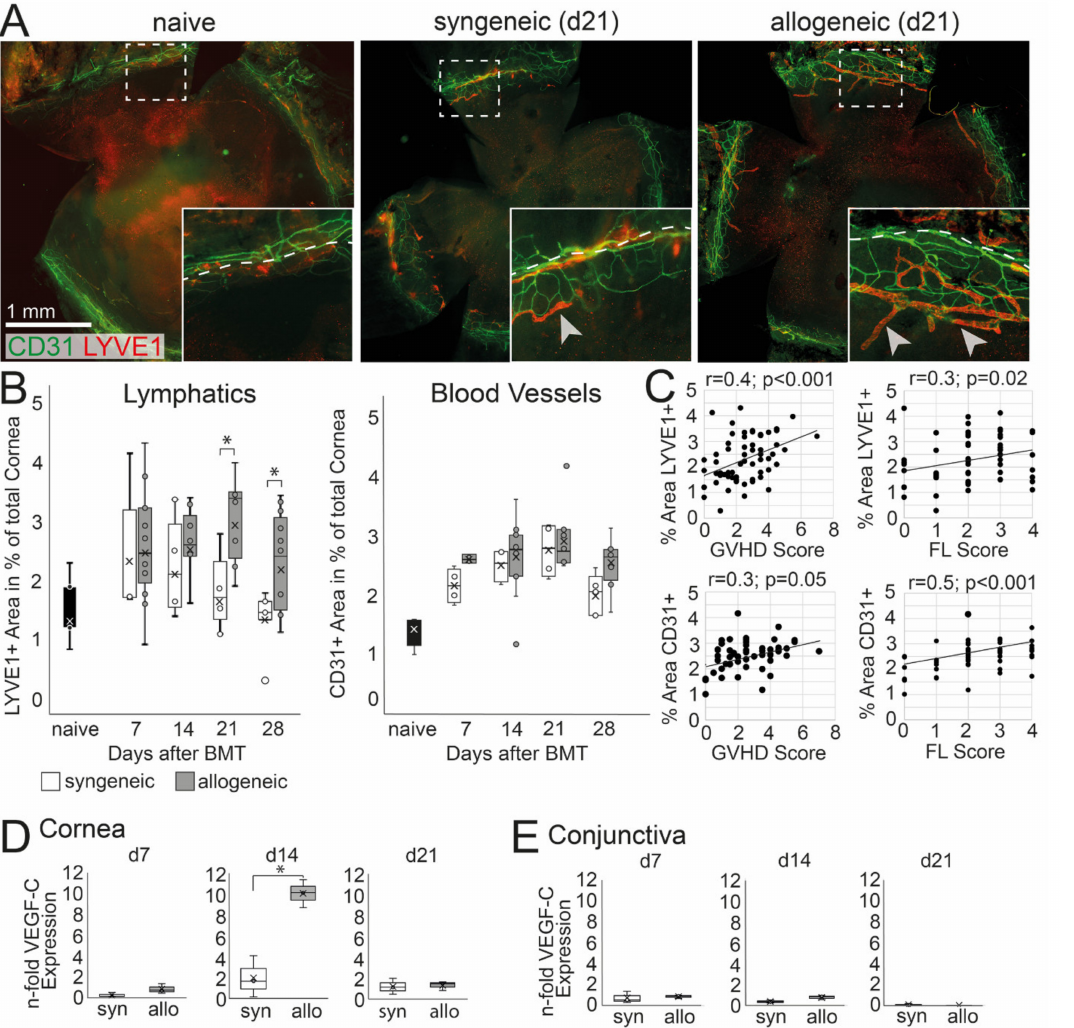
Figure 4. Corneal hem- and lymphangiogenesis in oGVHD. ( A ) Exemplary corneal flat-mount samples of naïve, syngeneic, and allogeneic transplanted mice 21 days after BMT (CD31 = green, Lyve1 = red; bar = 1 mm). ( B ) Average area covered